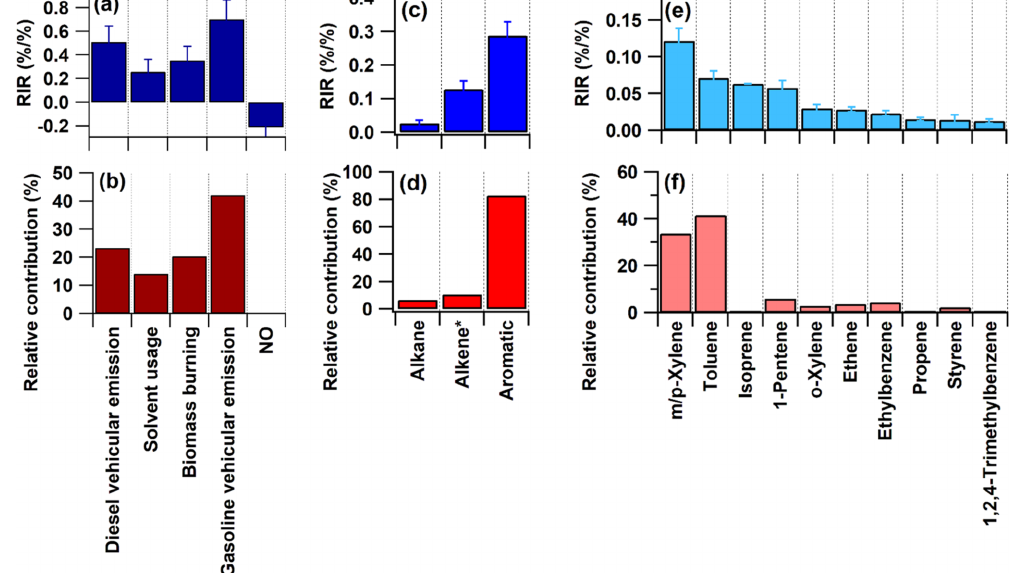
Figure 8. The mean RIR values of different sources (a) and their contributions to photochemical O 3 formation (b) . The mean RIR values of different VOC groups (c) and their contributions to photochemical O 3 formation (d) . The mean RIR values of top 10 VOCs (e) and their contributions to photochemical O 3 formation (f) . The error bars represent the standard error of the mean RIR values. Alkene includes both acetylene and alkenes except